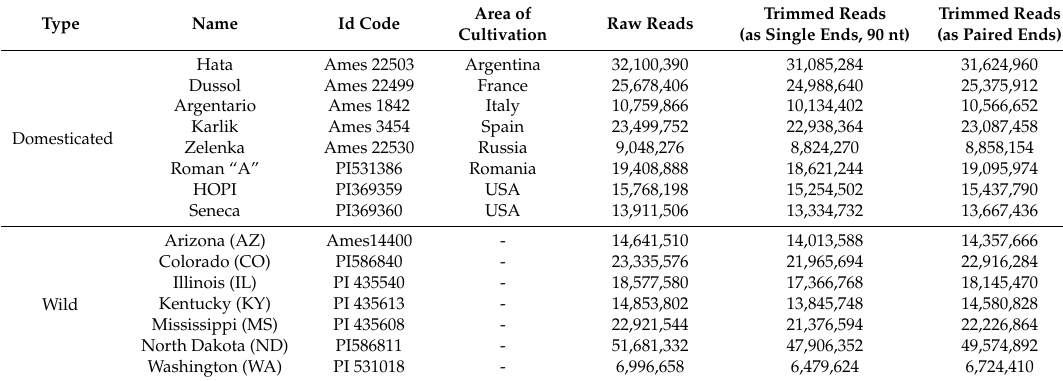
Table 1. Sunflower genotypes used in this study. For each genotype, the United State Department of Agriculture (USDA) identification code, the area of cultivation for domesticated genotypes, and the number of reads sequenced by the Illumina technique are reported. Reads were trimmed at 90 nt and used in analyses as single ends for measuring LTR-retrotransposons (LTR-REs) abundance. For analyzing the proximity between LTR-REs and genes, paired ends were used and no specific length was